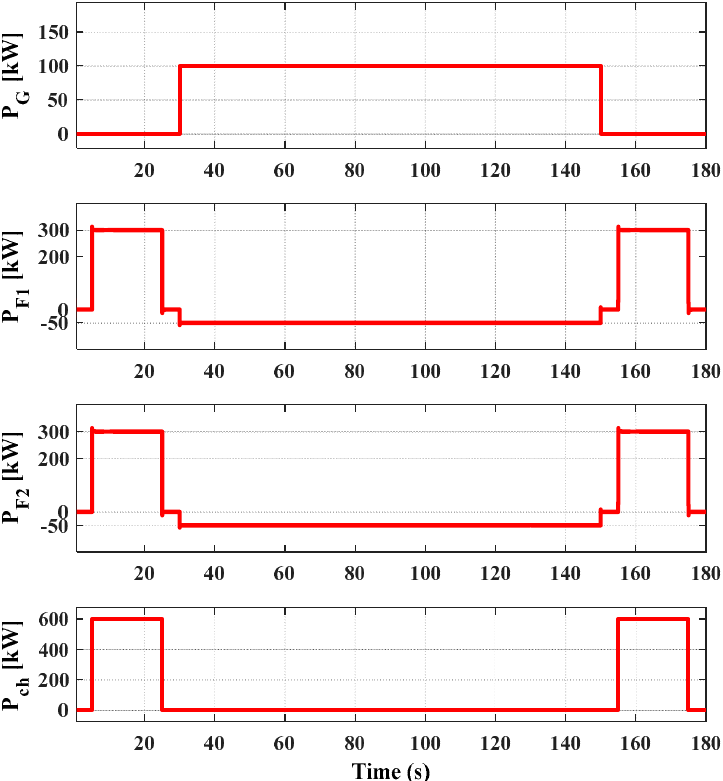
Figure 15. Simulation results for the electric power of grid, FES1, FES2, and charger.